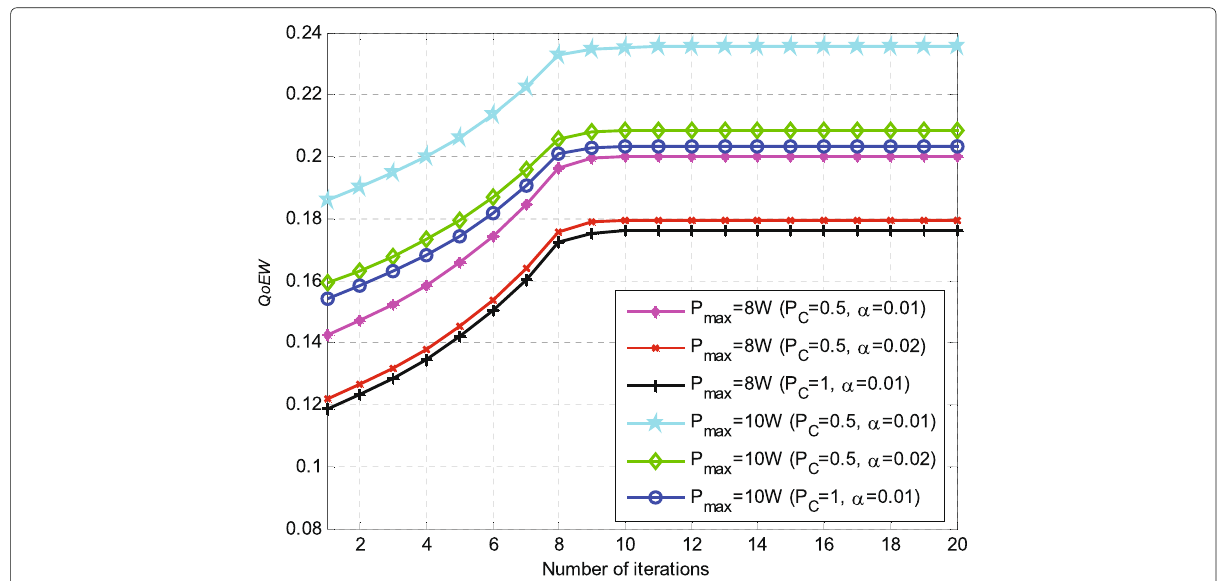
the interference thresholds of multiple PUs. In addition, the impacts of the fixed power, the dynamic circuit power consumption factor and the drain efficiency of PAs on QoEW are also given. In our future work, we will extend this framework for multiple SUs with various multime- dia services and different QoE requirements under green communications